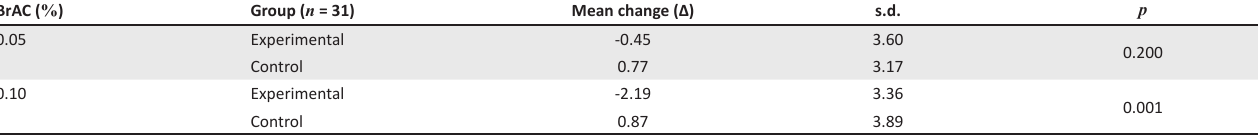
TABLE 7: Population sample percentage of the compensated and uncompensated heterophoria at 0.05 % blood respiratory alcohol concentration and 0.10 % blood respiratory alcohol concentration for distance and near. Distance and near N BrAC ( % ) Compensated ( % ) Uncompensated ( % ) Distance 31 0.05 Near 31 BrAC, blood respiratory alcohol concentration. TABLE 8: Mean change for Near Point of Convergence at blood respiratory alcohol concentration levels of 0.05 % and 0.10 % . BrAC ( % ) Group ( n = 31) NPC break NPC recovery Mean change (cm) 0.05 Experimental